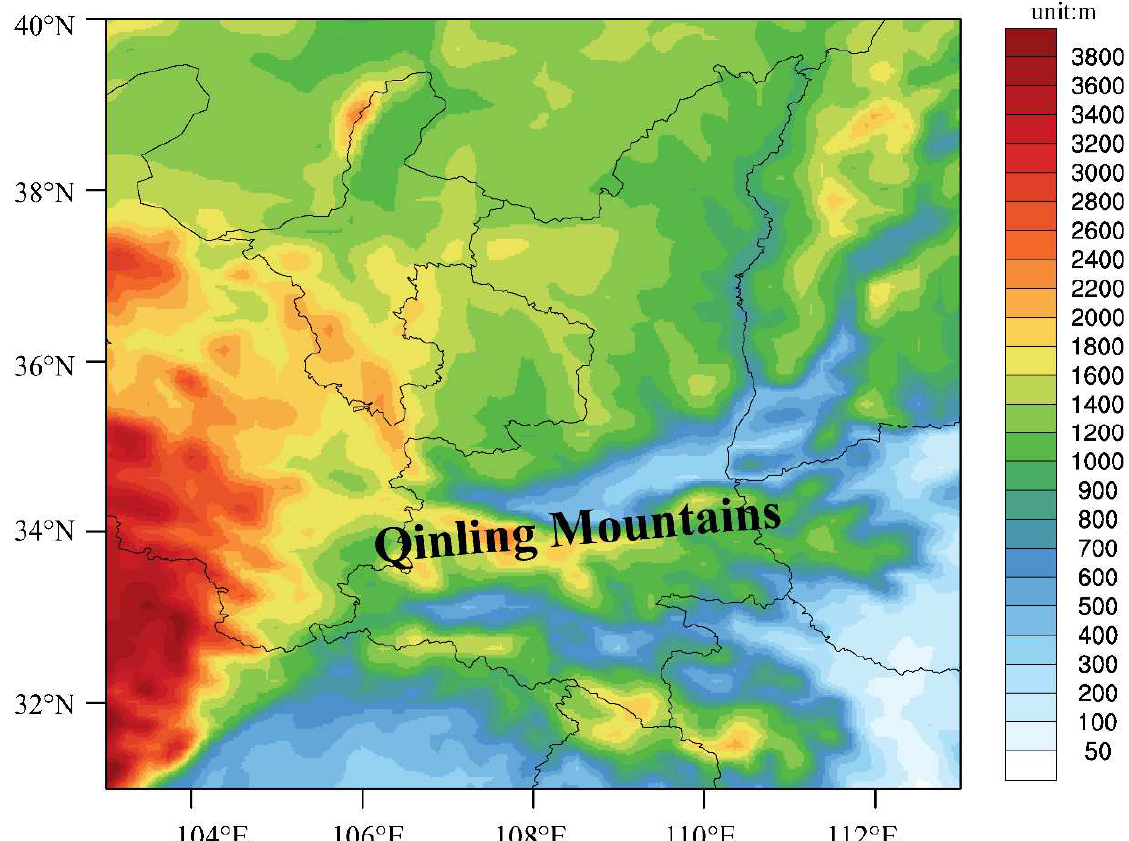
Figure 1. Study area: Terrain of Qinling Mountains and their surrounding